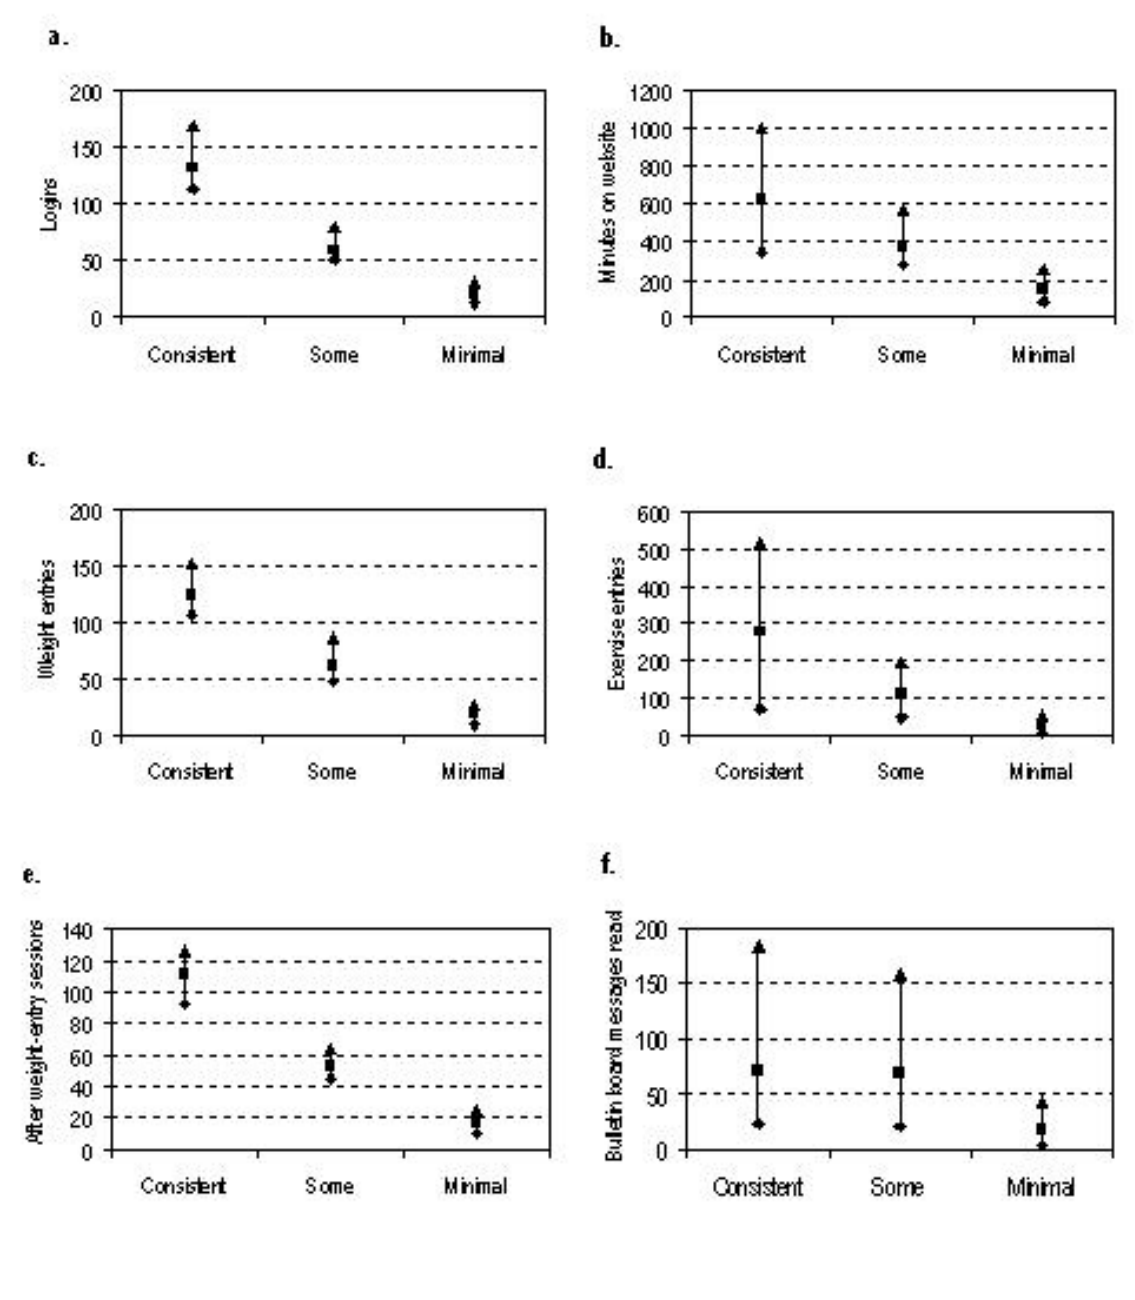
Figure 1. Use of various website features for consistent (n = 212), some (n = 61), and minimal (n = 75) use categories shown as median (square) with first (diamond) and third (triangle)